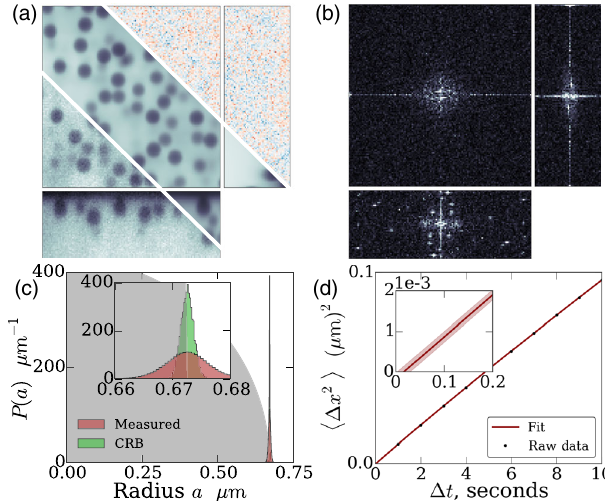
FIG. 2. Fitting the generative model to experimental data . (a) A representative image (lower left), its best-fit model (center), and the difference between the two (upper right), shown as cross sections in the xy , xz , and yz planes. The residuals show nearly perfect Gaussian white noise at the expected signal-to-noise ratio, demonstrating the quality of the generative model. (b) The Fourier power spectrum of the same residuals, displayed as three q q q orthogonal slices in the q , q , and q planes. In addition x y x z y z ¼ 0 and q ¼ 0 to scanning noise, visible as the stripes along q x z as well as the isolated poles, excess power is visible at scales larger than the particles themselves but smaller than the features given by the illumination field (ILM). These residuals are associated with the incomplete description of the point-spread function. (c) PERI measures the particle radius within an uncertainty of 3 – 4 nm, as estimated from changes in featured particle radii with time (red histogram) measured by tracking approximately 1200 particles over 800 time points. Improving the description of the PSF would allow for radii to be featured at the CRB (green histogram), with a precision of 1 nm. (d) The experimental mean-squared displacement along the x direction h Δ x 2 i (black dots; error bars are smaller than symbol size) from approximately 1200 particles measured over 800 time points provides an estimate of PERI ’ s average positional errors. Extrapolating the fitted mean-square displacement (red curve; the shaded band denotes the fit uncertainty) to t ¼ 0 gives a positional error indistinguishable from 0 nm. The mean-square displacement along y and z provide the same